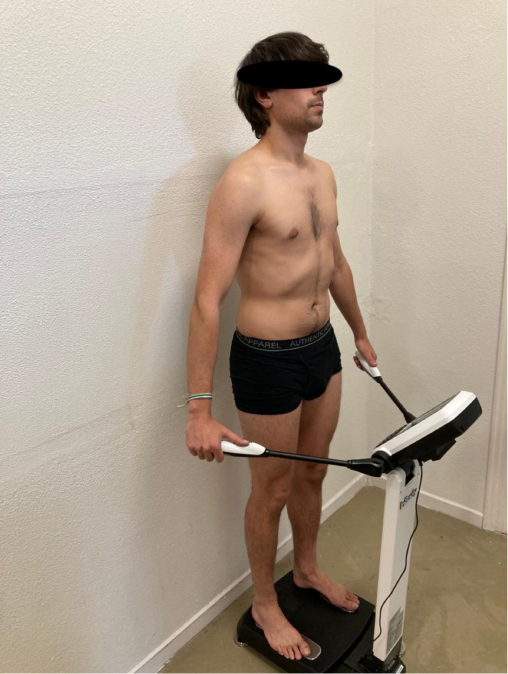
Figure 1. Body composition measurement using the bioimpedance